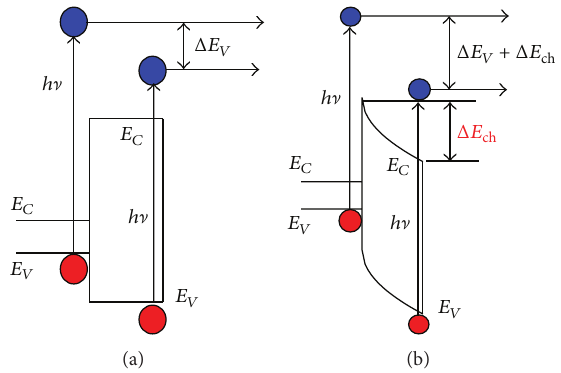
Figure 1: Schematic of the VB offset ( Δ𝐸 𝑉 ) determination from an external photoemission experiment. While in the ideal case of the uncharged insulator (panel (a)) the energy difference between electrons emitted from the VB tops of the semiconductor and insulator exactly corresponds to the VB offset, the X-ray induced charging of the insulator (panel (b)) introduces an energy shift Δ𝐸 due to variation of the electrostatic potential across the insulating layer leading to a systematic error in the measured band offset